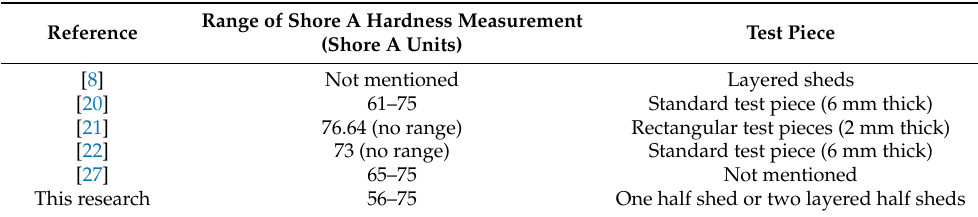
Table 3. Comparative study and contribution to the range of shore A hardness measurement on new (unused) HTV silicone rubber with ATH filler used as composite insulators’ housing material and the way of the preparation of the test pieces.